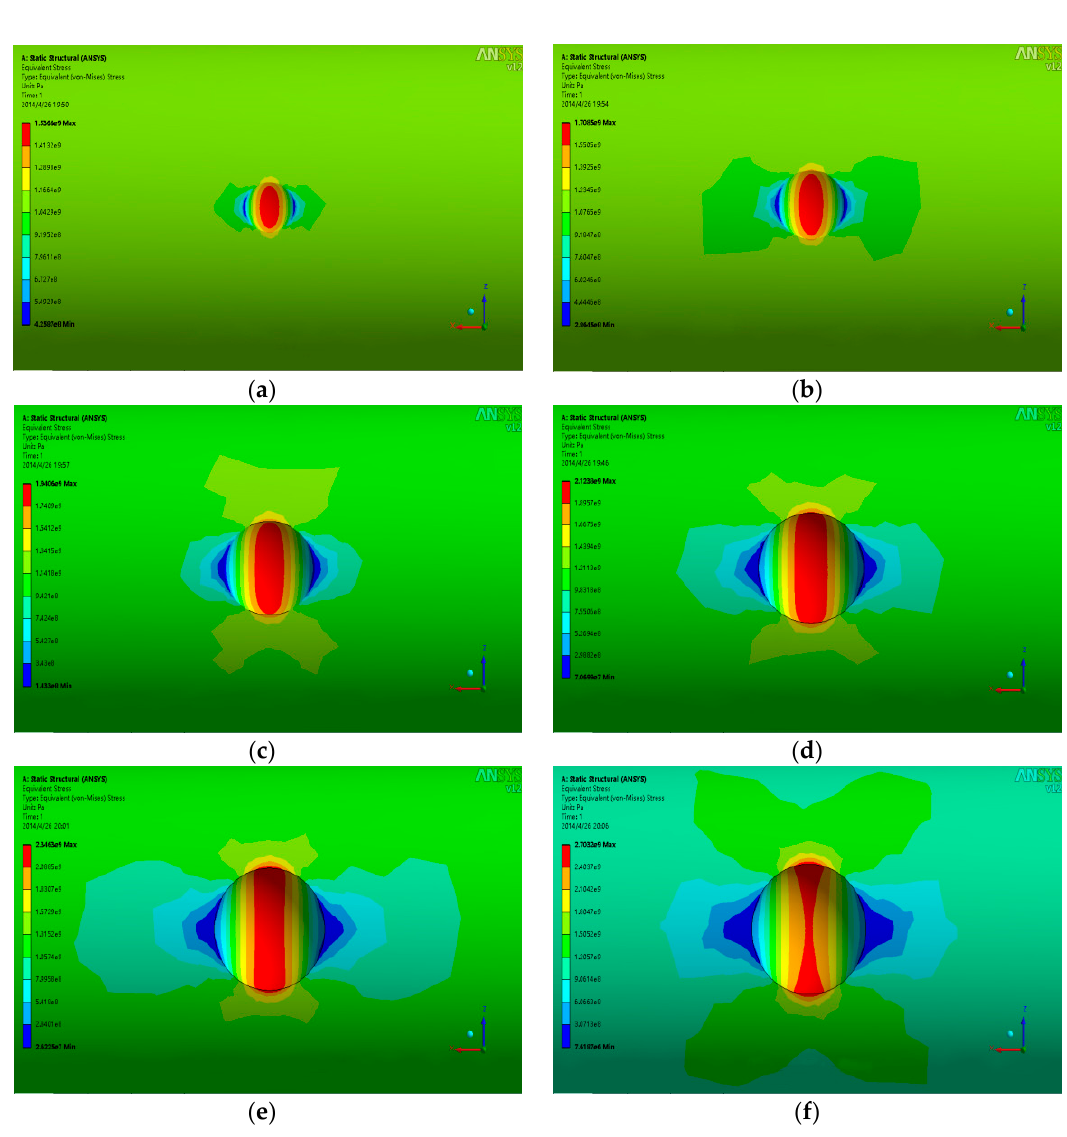
Figure 15. Pit stress diagram (considering depth only). Pit depth ( a ) d = 0.1 mm; ( b ) d = 0.2 mm; ( c ) d = 0.4 mm; ( d ) d = 0.6 mm; ( e ) d = 0.8 mm; ( f ) d = 1 mm.